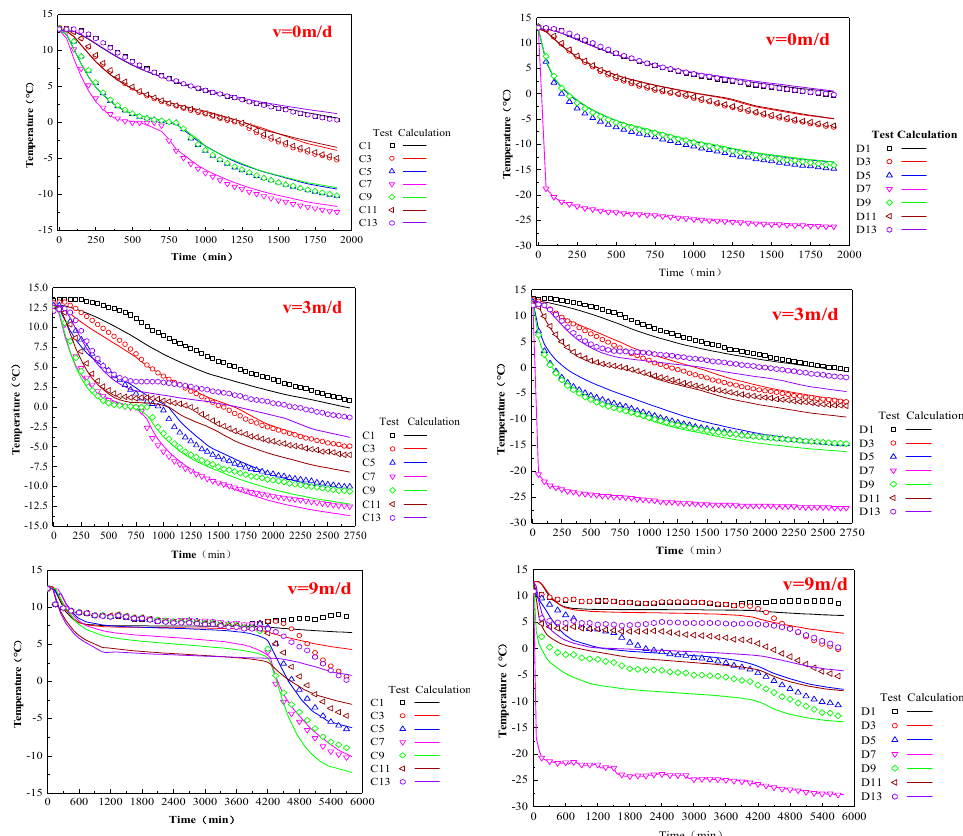
Figure 7. Comparison of temperature simulation results and measured results.